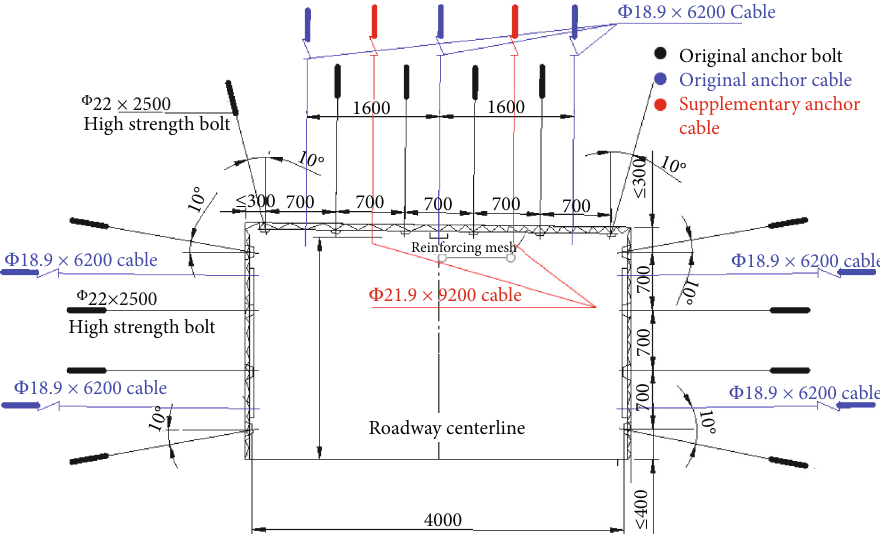
Figure 12: Layout of anchor cables for the reinforcement roof in the